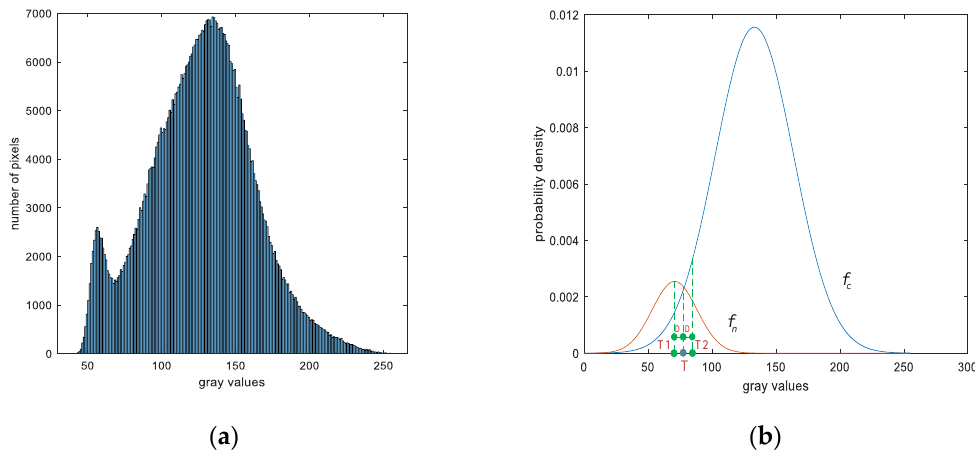
Figure 2. The fitting effect of GMM for the SAR image. ( a ) The histogram of gray values. ( b ) The fitted GMM distribution curves of water ( f n ) and non-water ( f c